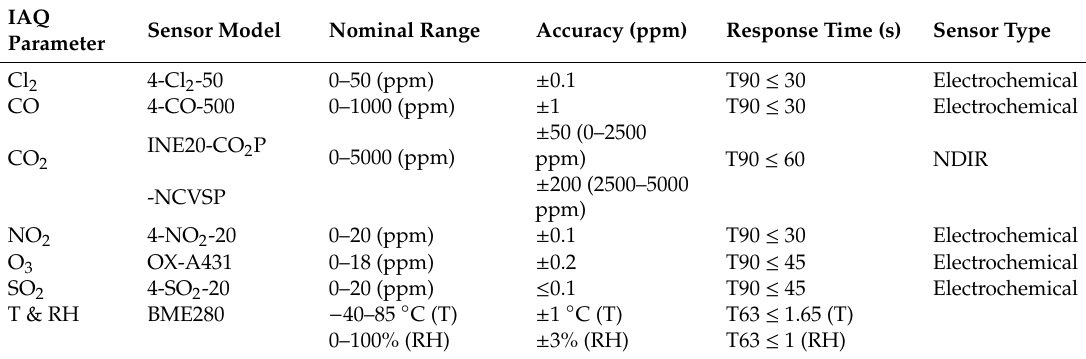
Table 1. Specifications of the used sensors, where BME280 is Humidity—temperature and pressure sensor, T90 is the amount of time that it takes for the detector to measure 90% of the maximum concentration level, and T63 values indicate how long the measurement takes to reach